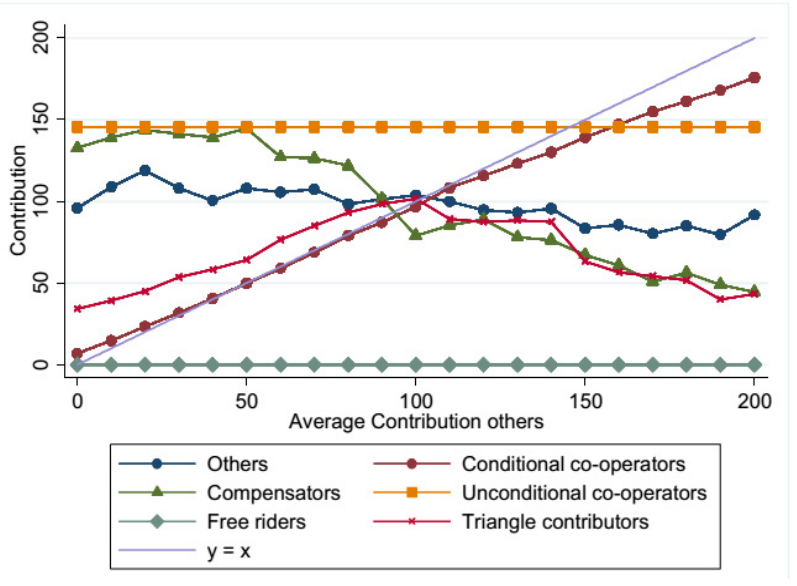
Figure 1. Average contribution (Strategy method), all subjects ( n =